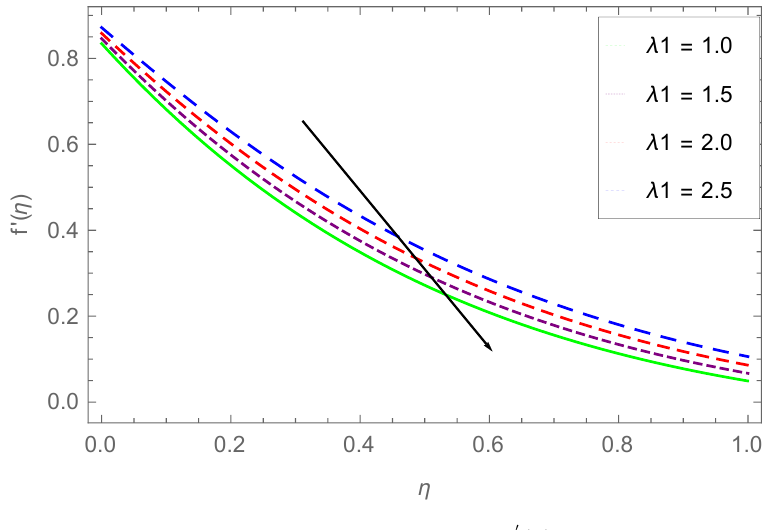
Figure 6. Impact of λ 1 over f (cid:48) ( η )